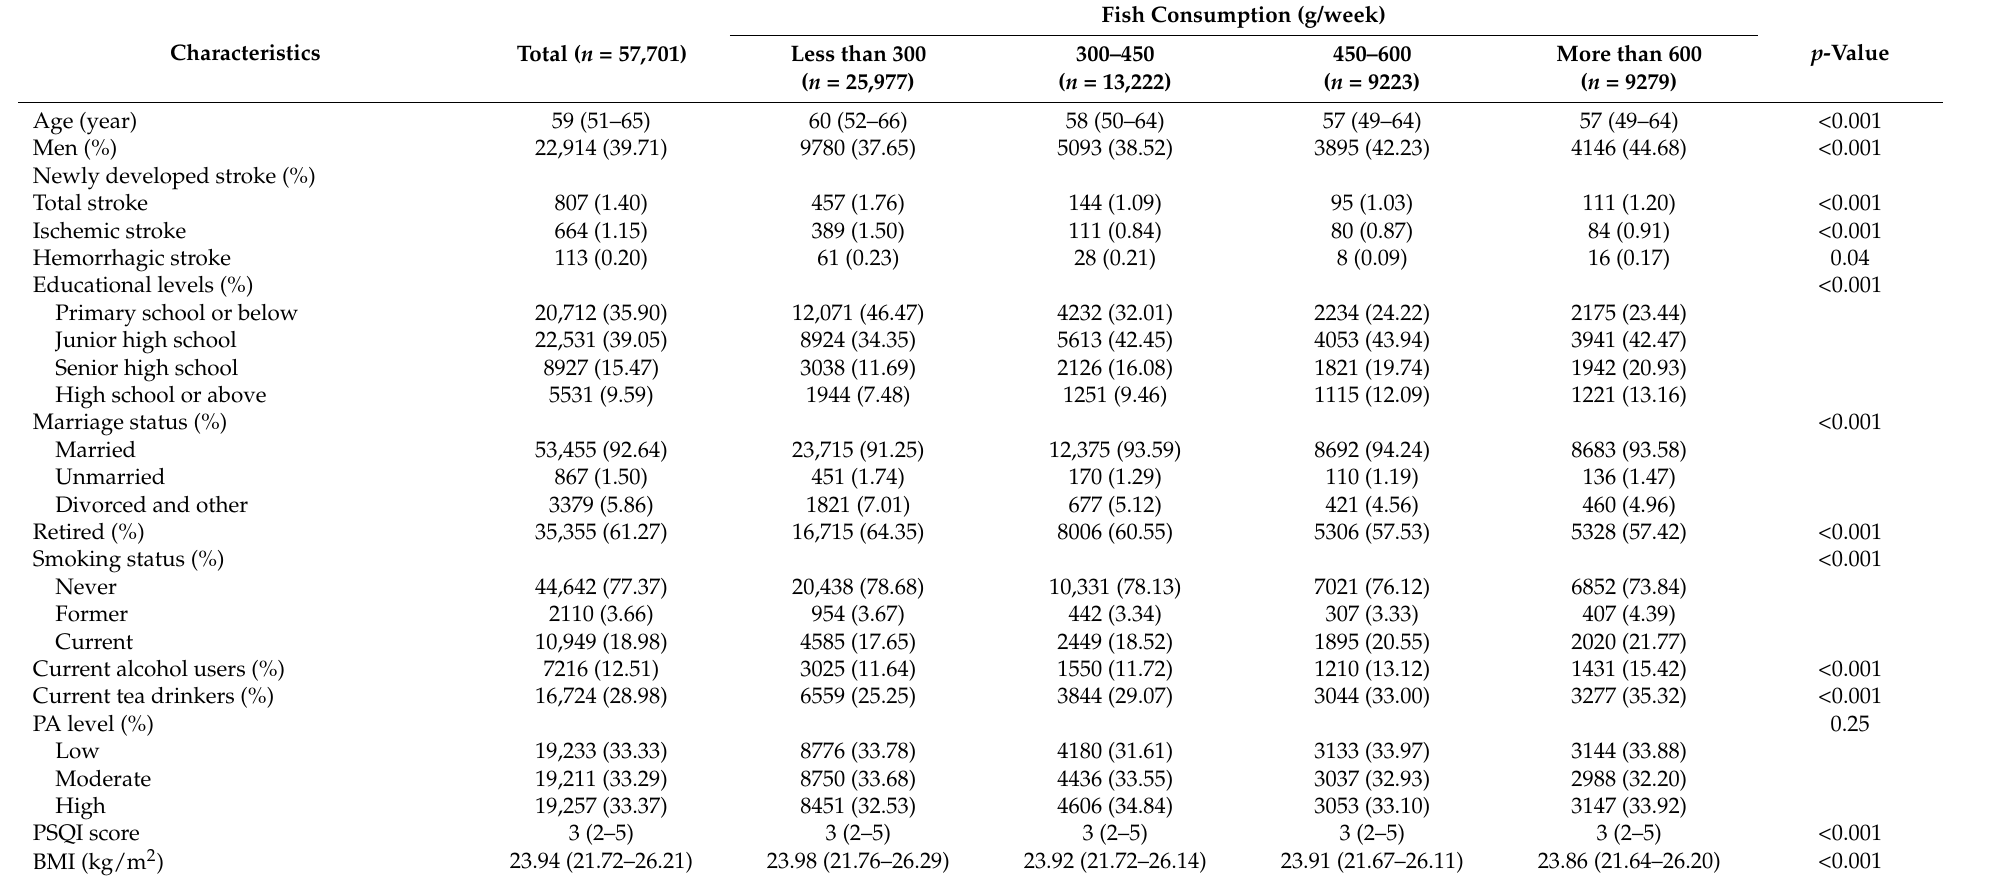
Table 1. Baseline characteristics of participants according to four categories of fish